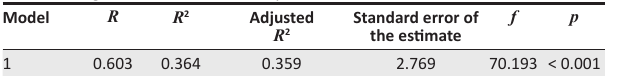
TABLE 7: Regression model summary.